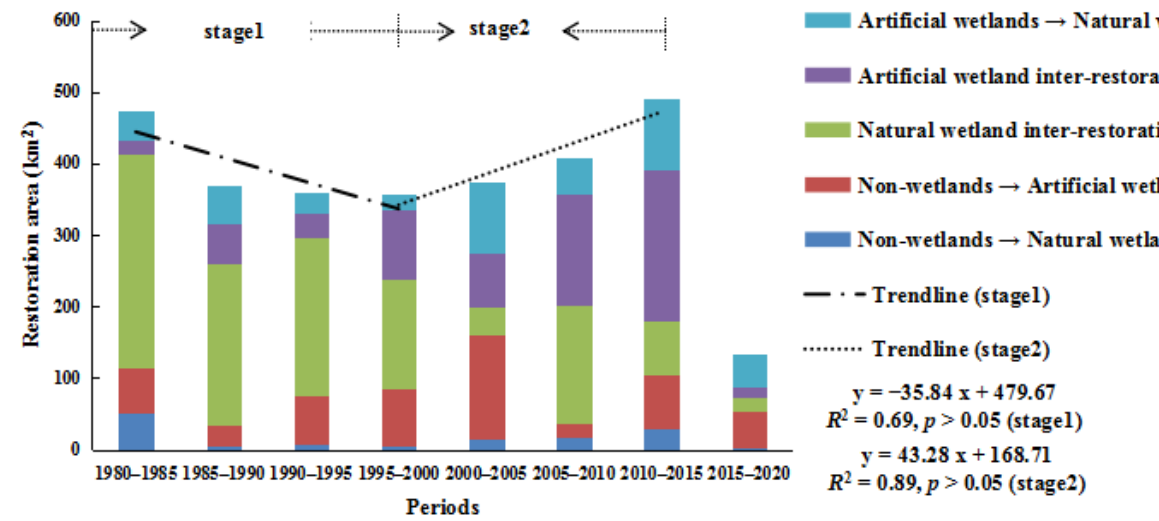
Figure 6. Restoration types of coastal wetlands in different periods in northern Jiangsu, China.